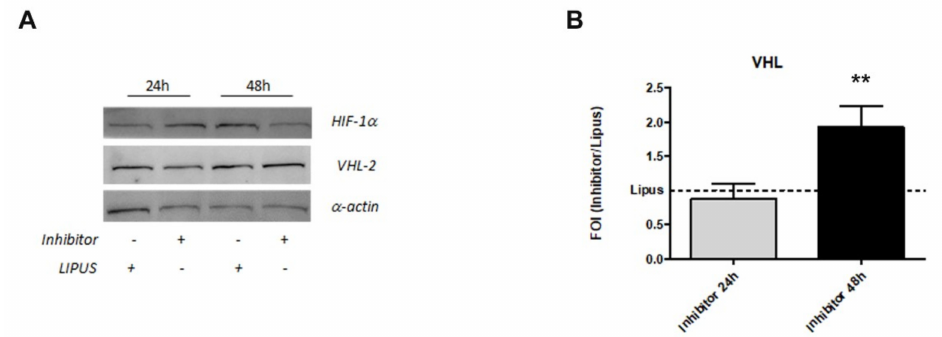
Figure 6. Effects of miR-31-5p induced by LIPUS on HIF-1 α protein modulation evaluated by HIF-1 α proteins analysis ( A ) and by VHL ( B ) gene expression. Western blot analysis for: HIF1- α and VHL-2, and α -actin proteins were performed on total cells extract ( A ). Quantitative RT-PCR data are expressed as fold of change (FOI) in gene expression (2 − ∆∆ C t ) and occurred in Inhibitor/LIPUS compared to Scramble/LIPUS. Student’s t test: **, p <